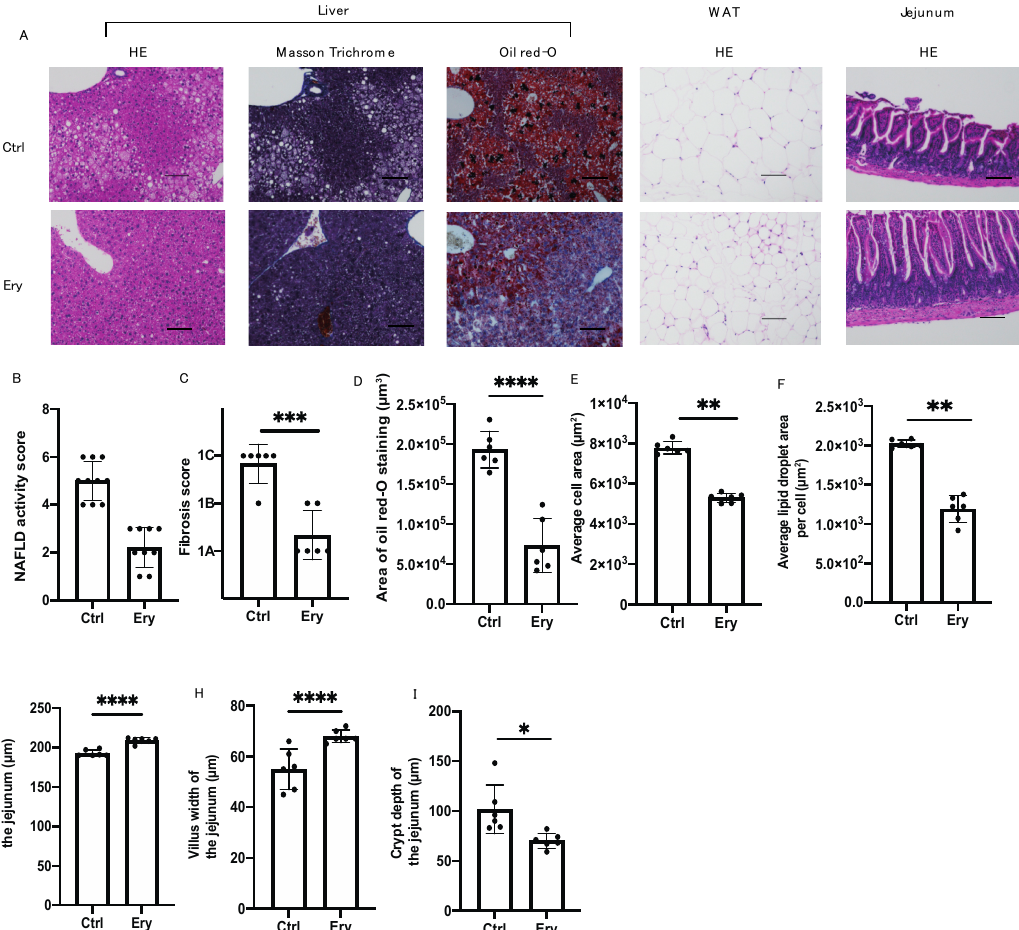
Figure 3. Erythritol reduced fat accumulation in the liver, liver fibrosis, adipocyte size, and small intestinal inflammation. ( A ) Representative images showing the histological features of the liver, white adipose tissue, and jejunum of the mice. ( B ) NAFLD activity score of the liver ( n = 6). ( C ) Fibrosis score of the liver ( n = 6). ( D ) Oil Red O–stained area of the liver ( n = 6). ( E ) Average cell area of white adipose tissue ( µ m 2 ) ( n = 6). ( F ) Average lipid droplet area per cell ( µ m 2 ) ( n = 6). ( G ) Villus height of the jejunum ( n = 6). ( H ) Villus width of the jejunum ( n = 6). ( I ) Crypt depth of the jejunum ( n = 6). Scale bar: 100 µ m. Data have been represented in terms of mean ± SD values. * p < 0.05, ** p < 0.01, *** p < 0.001, and **** p < 0.0001, using an unpaired t